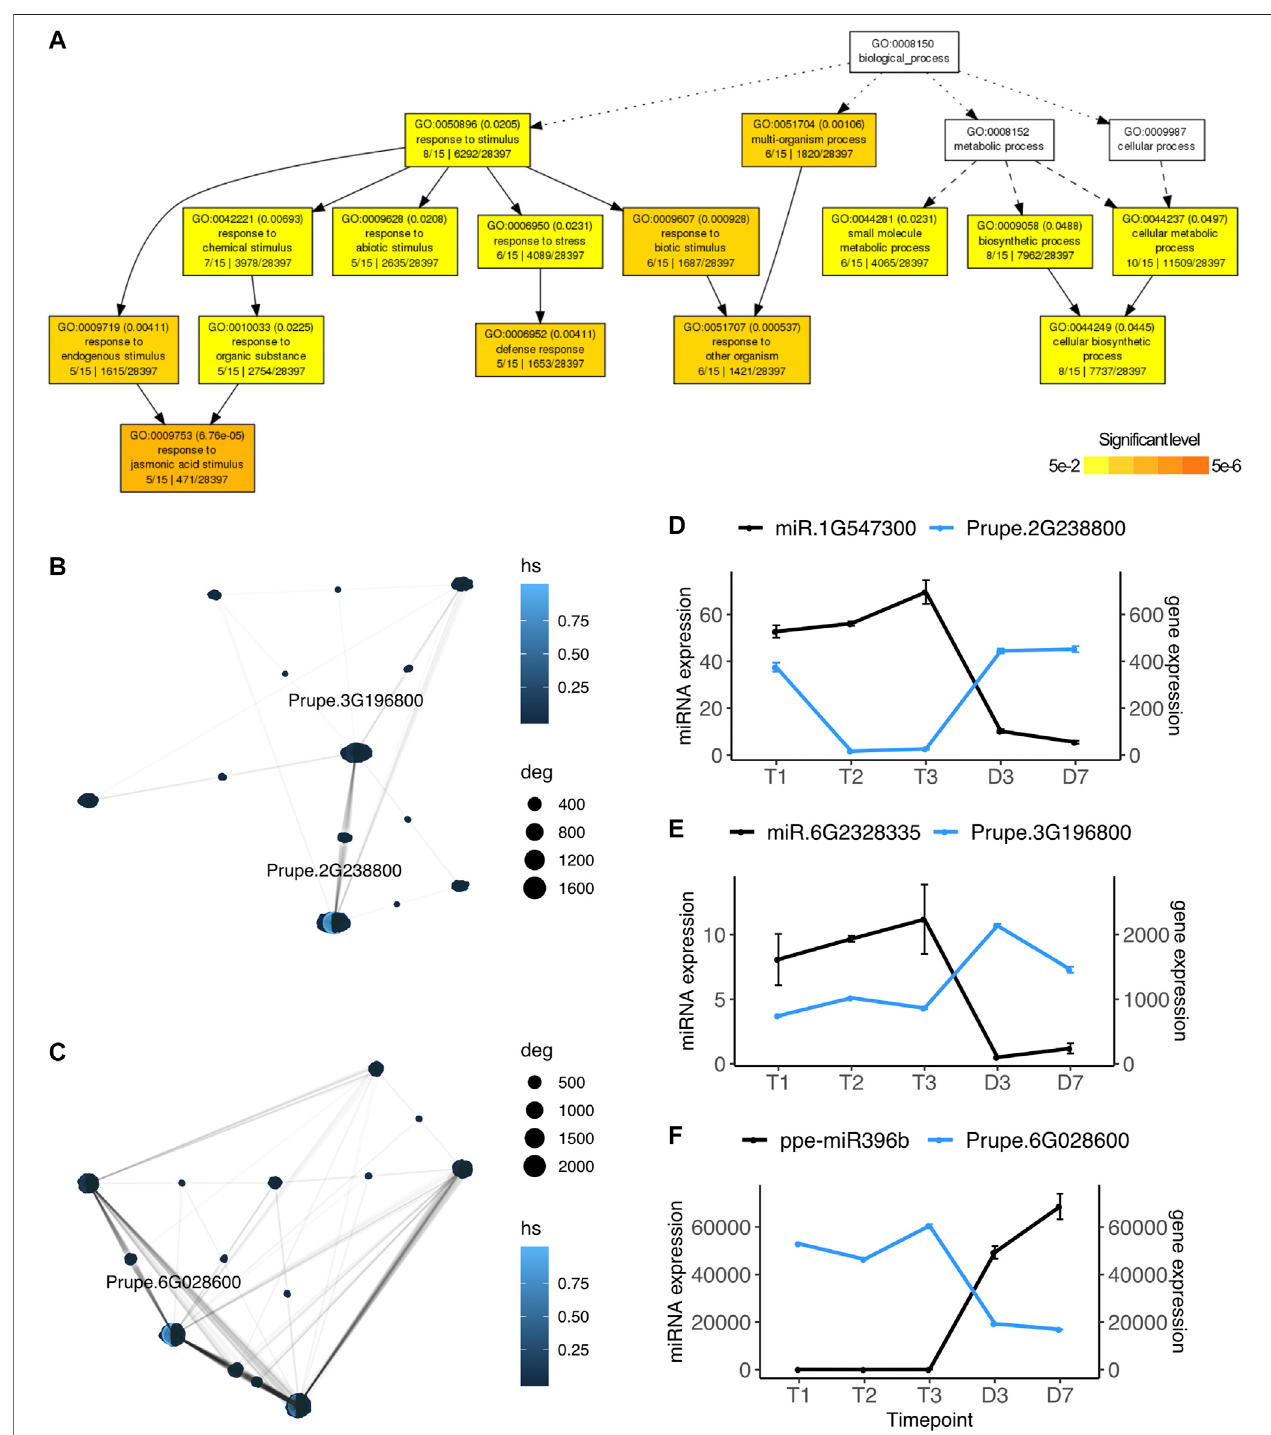
FIGURE 3 | microRNA regulated pathways during dormancy release (A) Gene ontology network of microRNA targeted genes that displayed opposite expression pro fi les. GO terms in white indicated no signi fi cance (B) Gene interaction network of upregulated genes targeted by downregulated microRNA (C) Gene interaction networkofdownregulatedgenestargetedbyupregulatedmicroRNA (D) – (F) Geneexpressionpro fi les(mean ± SE)ofmicroRNAs(inblack)andtheirtargetedhubgenes (in blue) identi fi ed by the networks (B) and (C) . Prupe.2G238800, Rubisco activase; Prupe.3G196800, acetoacetyl-CoA thiolase; Prupe.6G028600, heat shock protein